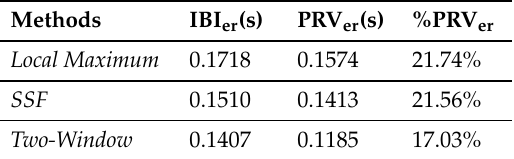
Table 3. The average PRV errors.